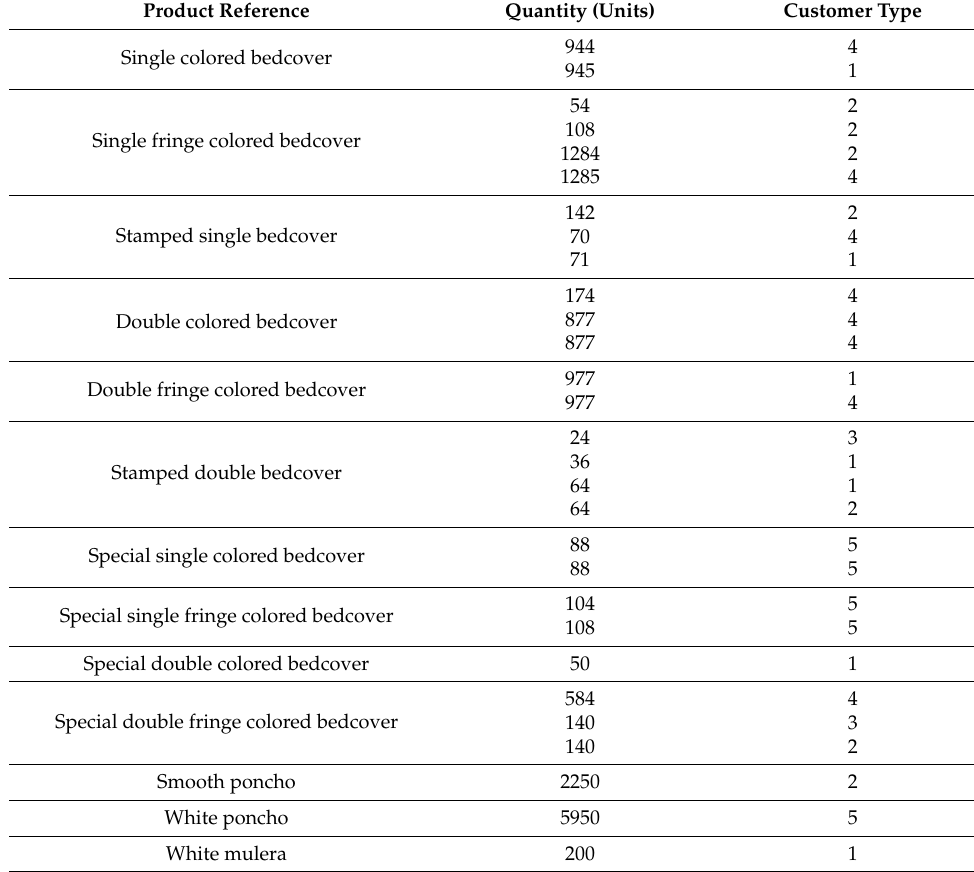
Table A3. Customer type and order quantity.